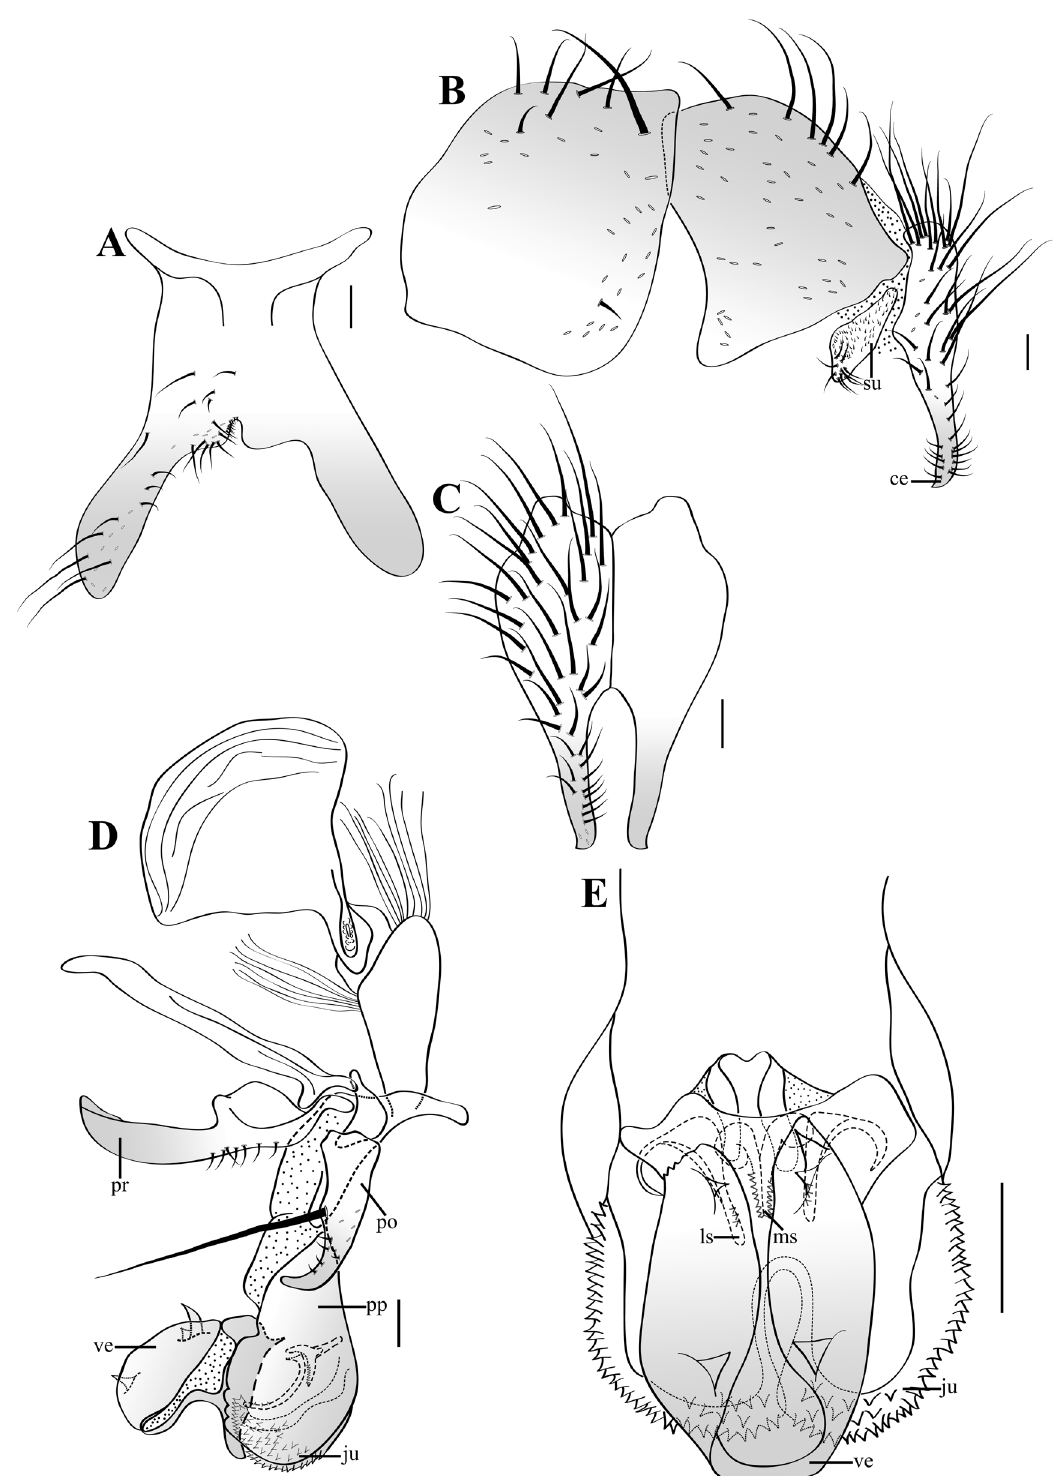
Fig. 6. Dexosarcophaga limon sp. nov., ♂, holotype (INBio [lost]). A . Sternite 5, ventral view. B . Syntergosternite 7 + 8, epandrium, cercus and surstylus, lateral view. C . Cerci, posterior view. D . Phallus and associated structures, lateral view. E . Distiphallus, ventral view. Abbreviations: see Material and methods. Scale bars = 0.1